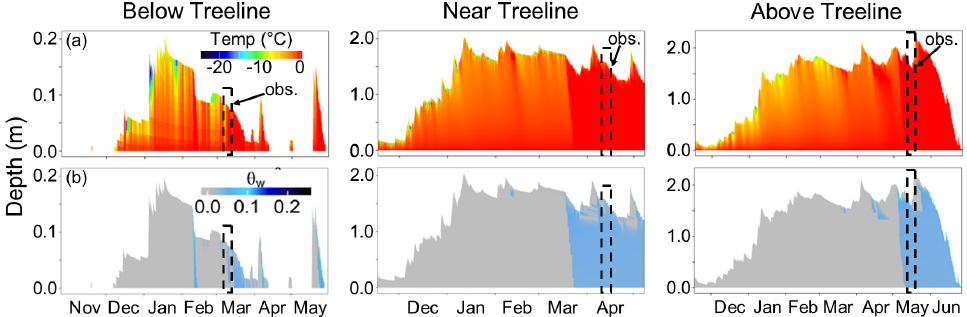
Figure 2. Results of SNOWPACK simulations of the entire water year for below-treeline (BT), near-treeline (NT), and above-treeline (AT) study sites. Results shown are (a) snow temperature and (b) volumetric liquid water content ( θ w ) with the observation (obs.) and SnowTOUGH simulation period highlighted in the dashed box. Note that the axes have different scales for each site and that these are not used as input for the SnowTOUGH simulations but used for context in the timing of observations to seasonal